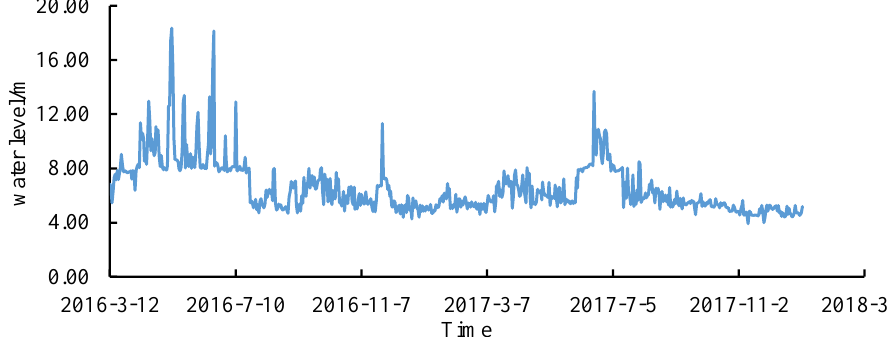
Figure 7. Process diagram of upstream water level.